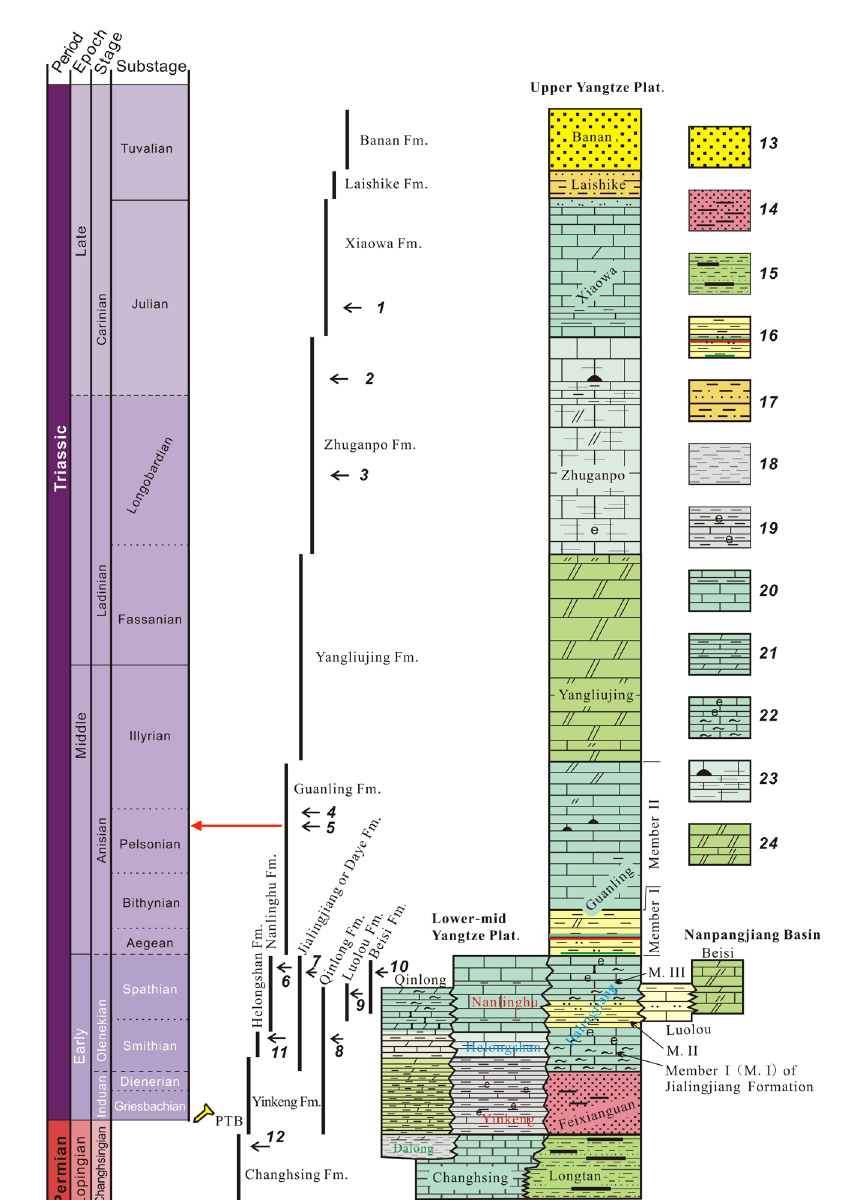
Figure 2. Schematic stratigraphic column illustrating the Permian and Triassic formations of the Yangtze Platform, with the age of the Luoping Biota marked by a red arrow. The different formations and biotas are dated according to biostratigraphy and radiometric dates, all compared with the international geological column. Numbered vertebrate-bearing units, from 1 to 12, are 1, Guanling biota; 2, Xingyi biota; 3, reptile layers below the Xingyi biota; 4, Panxian biota; 5, Luoping biota; 6, fishes and reptiles from the Nanlinghu Formation in Chaohu; 7, fishes from the Daye Group in Huangshi, and reptiles from the Jialing- jiang Formation in Nanzhang and Yuanan, Hubei Province; 8, fishes from the Qinglong Formation in Jiangsu; 9, fishes from the upper Luolou Group in Guangxi Province; 10, reptiles from the Beisi Formation in Guangxi; 11, fishes from Helongshan Formation in Chaohu; 12, fishes from the upper Changhsing Formation in Meishan. Major lithologies, numbered 13–24, are 13, siliciclastics; 14, siliciclastics with mudstone; 15, siliciclastics with mudstone and coal; 16, mudstone, silt and fine sandstone with colourful mudstone and silt sandstone interbeded; 17, mudstone and silt sandstone with shale; 18, mudstone; 19, mudstone with limestone intercalated; 20, limestone with mudstone interbedded; 21, limestone and marl with mudstone interbedded; 22, worm limestone and limestone with bioclastics; 23, medium- and thick-bedded limestones with chert nodules and laminated or bedded; and 24, dolomite with dolomitic limestone interbedded. Based on an image by Jinyuan Huang in Benton et al .